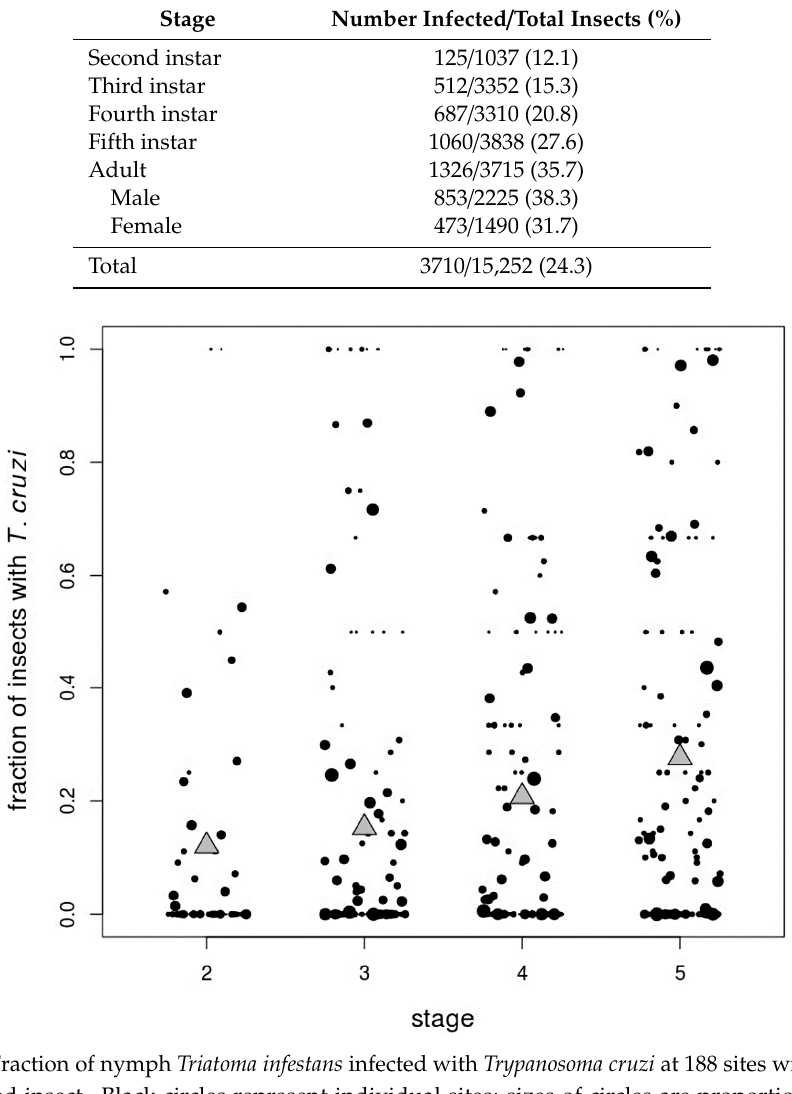
Figure 3. Fraction of nymph Triatoma infestans infected with Trypanosoma cruzi at 188 sites with at least one infected insect. Black circles represent individual sites; sizes of circles are proportional to the logarithm of the number of insects captured. The bottom edges of the gray triangles show the mean fraction of insects with T. cruzi across all infected sites. Table 2. Results of regression modeling to test two hypotheses of T. cruzi transmission to T. infestans . Model